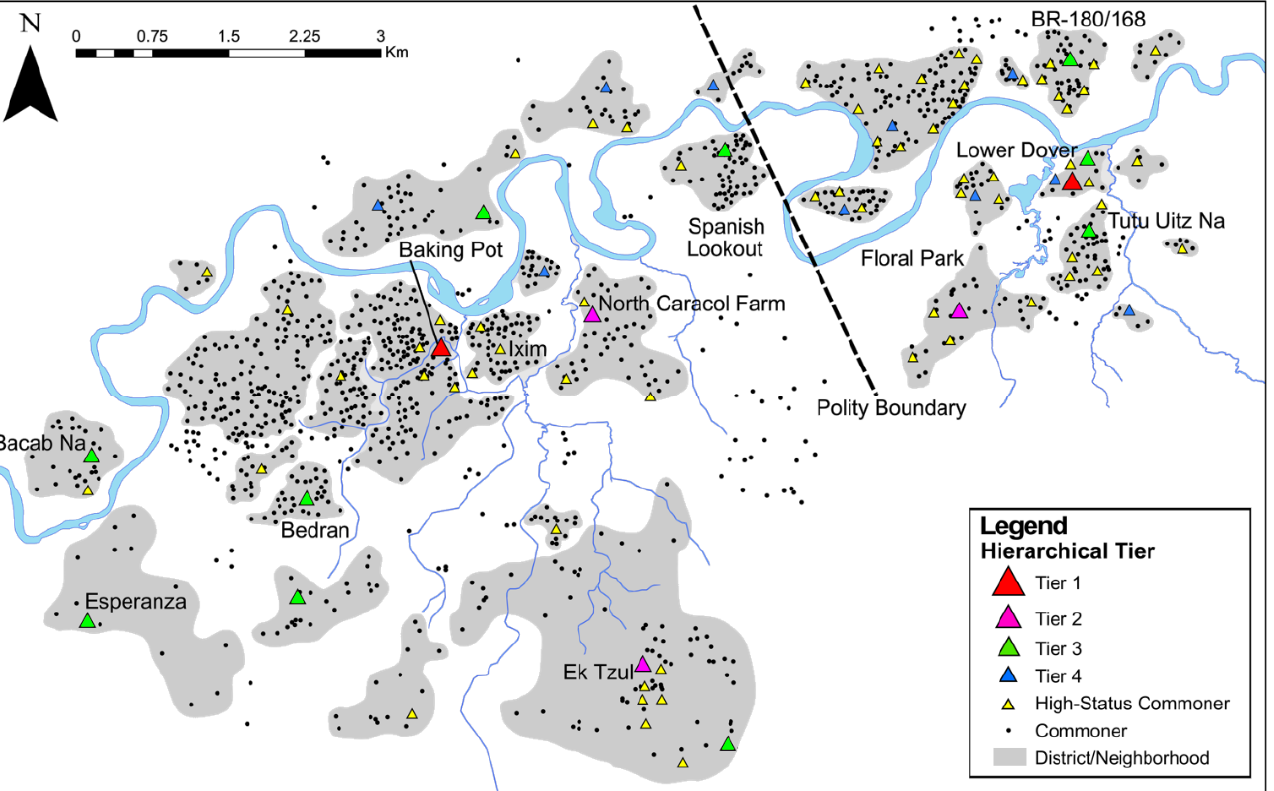
Figure 8. Reconstructed districts at Baking Pot and Lower Dover.